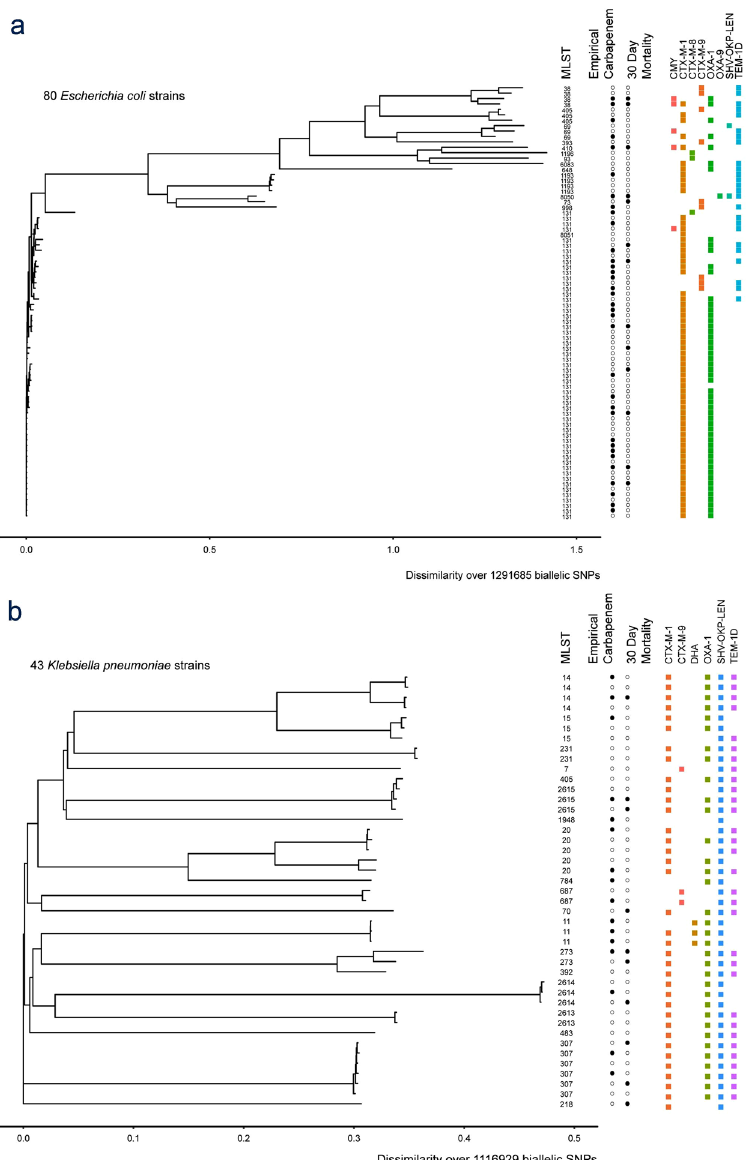
Figure 1. Phylogenetic trees for ( a ) E. coli and ( b ) K. pneumoniae isolates from this study. Neighbor joining trees were constructed from whole genome SNP profiles based on a reference-based analysis. MLST for each isolate is shown on the right. Black circles indicate yes (filled) or no (open) empirical carbapenem treatment and 30-day mortality, as indicated by the header. On the far right, colored squares indicate presence of a gene encoding the indicated resistance based on sequencing